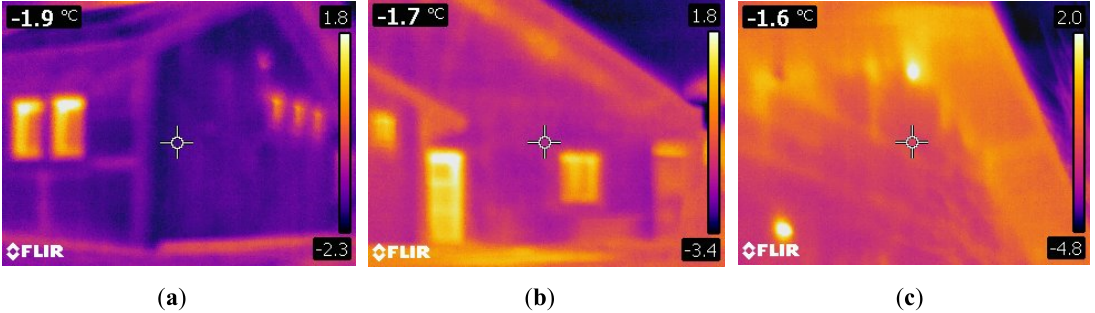
Table 3. Characteristics of the used sensors.